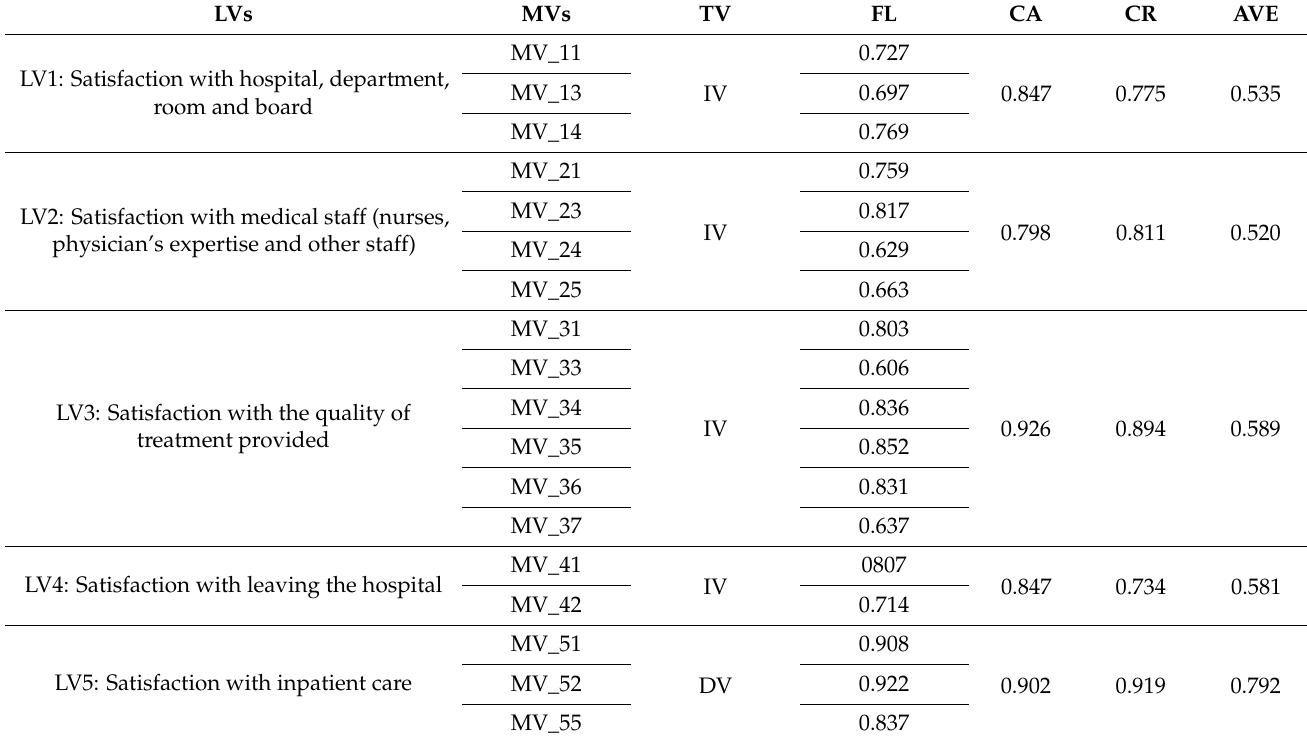
Table 1. Validities and